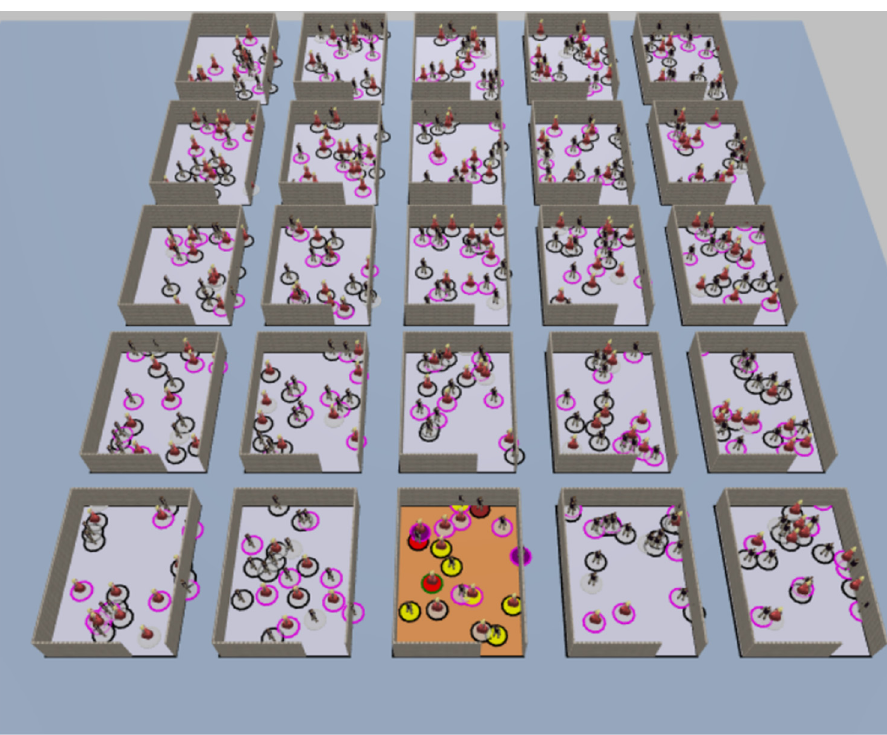
Figure 2. 3D animation of the AnyLogic simulation in action. Pictured is a school made up of 25 classes, each made up initially of 20 students. Virus appears to be present in the middle classroom on the bottom row.